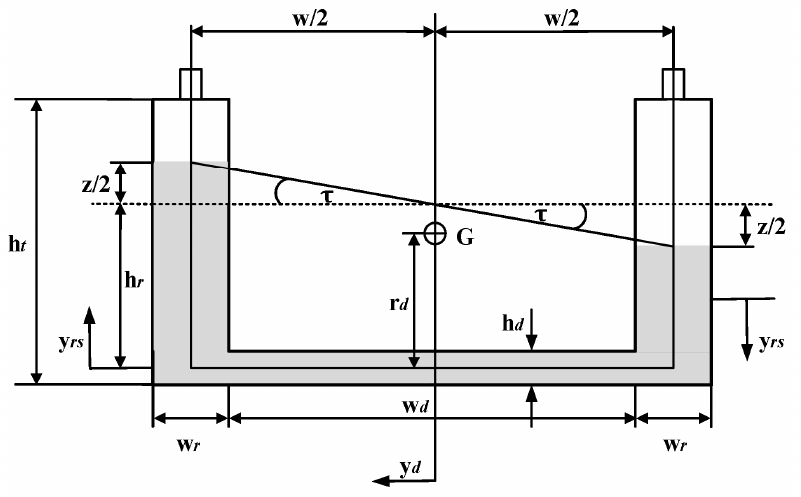
Figure 2. Structural parameters of the anti-rolling